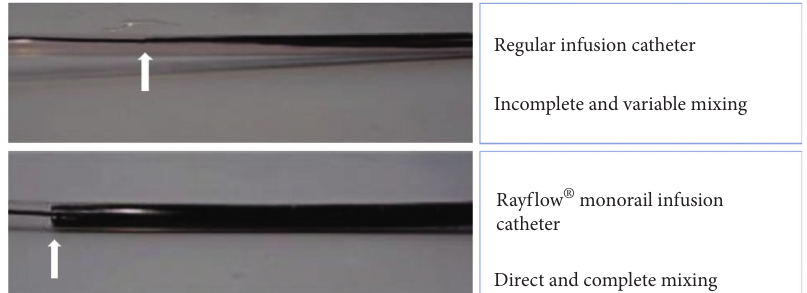
Figure 3: Difference in infusion between normal catheter and Rayflow. In the upper panel, an in vitro setup of a coronary artery is shown. The regular infusion catheter is placed in the “vessel” filled with saline and the infusate is dyed black with ink. It is visible that there is incomplete and variable mixing in case of the regular infusion catheter (arrow indicates tip of infusion catheter). In the lower panel, the Rayflow is used. Here immediate and complete mixing is shown, starting directly at the infusion holes (indicated by the